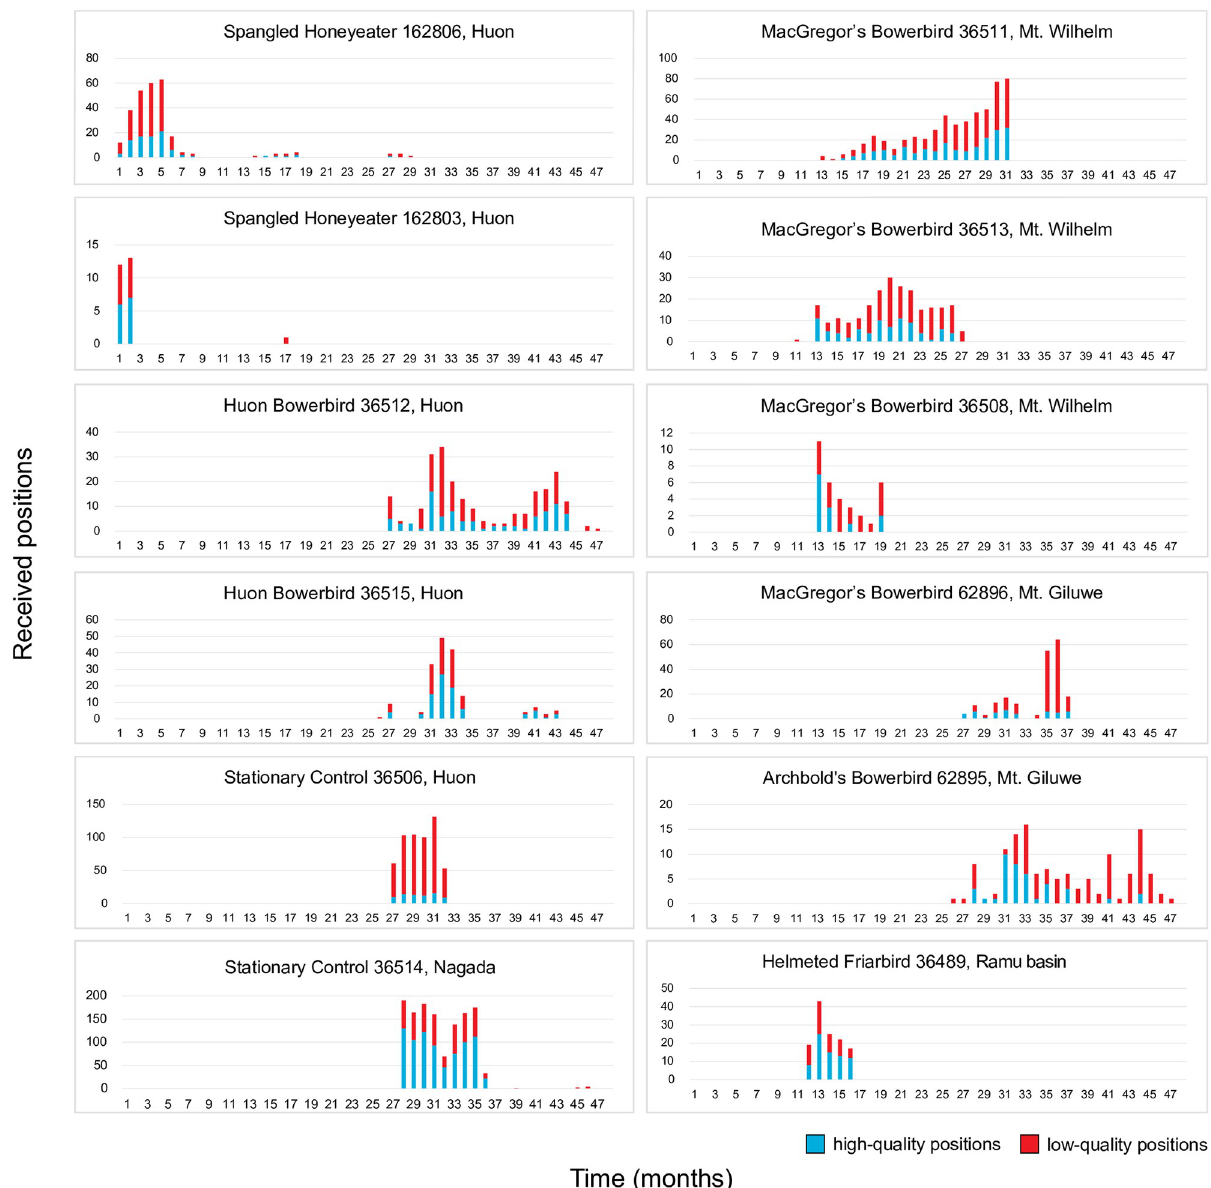
Fig 3. Transmission histories for tracked birds and stationary control transmitters. Time (in months) is measured on the x-axis; “1” corresponds to September 2016, and “47” corresponds to August 2020. All birds began transmitting within ten days after release. The y-axis measures number of positions obtained; note that scale varies between plots. Blue bars indicate high-quality points (Argos classes 1, 2, and 3); red bars indicate low-quality points (classes 0, A, B and Z). Three birds with < 10 high-quality positions are